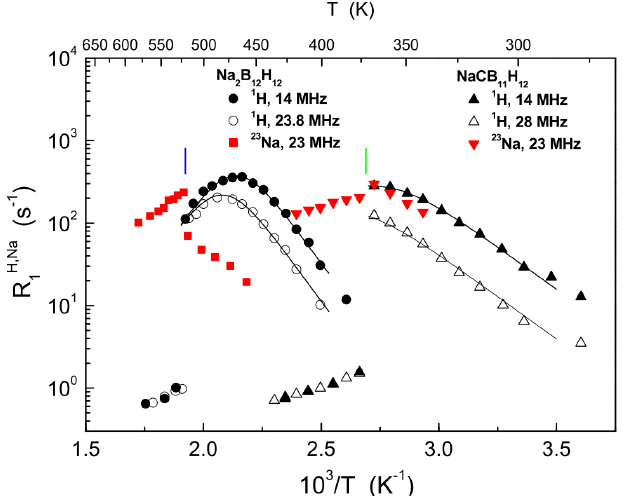
Figure 3. Effects of the order–disorder phase transitions in Na 2 B 12 H 12 [17] and NaCB 11 H 12 [71] on the 1 H and 23 Na spin–lattice relaxation rates. The black solid lines show the simultaneous fits of the standard model to the 1 H data in the ordered (low- T ) phases. The vertical bars indicate the phase transition temperatures for Na 2 B 12 H 12 (blue) and NaCB 11 H 12 (green).